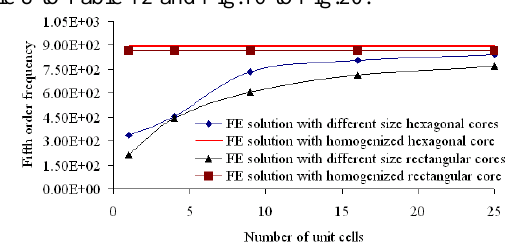
The fin te element m sandwich panels with the fferent d recta o- Fig.20eir eigen-frequencies and built and ogenized cores are ated as s der vibr hown in ation m the five or le 12 1 and Fig. to able 8 to Tab